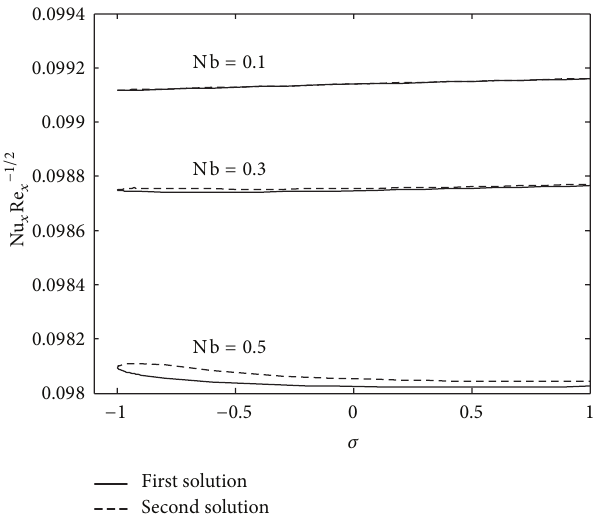
Figure 4: Variations of the local Nusselt number (heat transfer rate) with 𝜎 for different values of Nb when Nt = 0.5, Le = 2, Pr = 6.8, 𝛾 = 0.1, and S = 2.